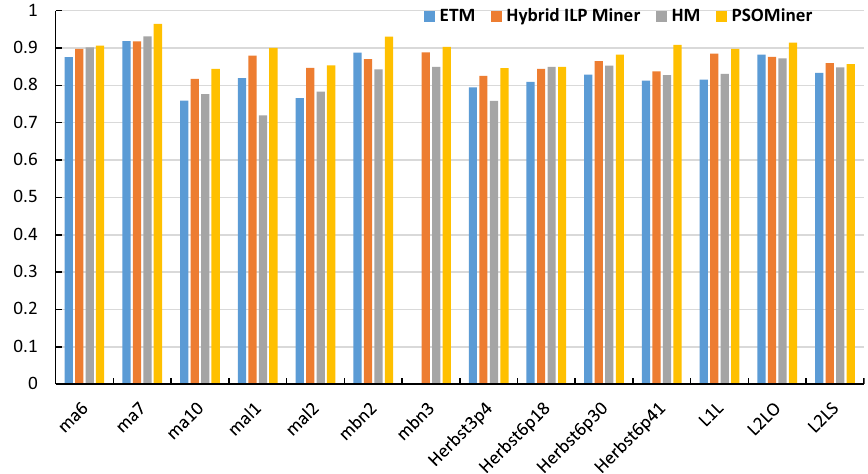
Fig. 8 f-score of four algo- rithms on event logs with 10% noise